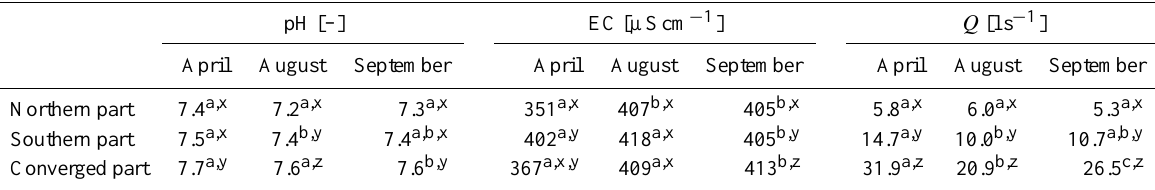
Table 2. Mean values of pH, EC and discharge ( Q ) for April, August and September for the northern stream, southern stream and after convergence.